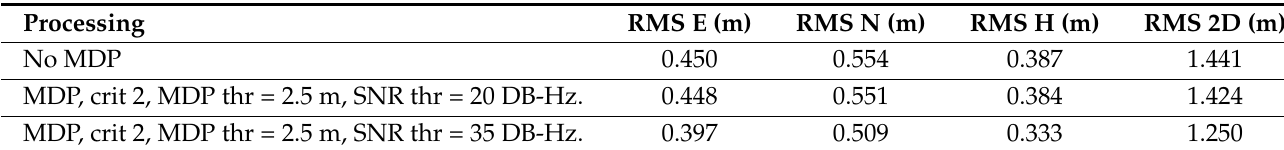
Table 5. Comparison between RMS obtained after MDP application, criterion